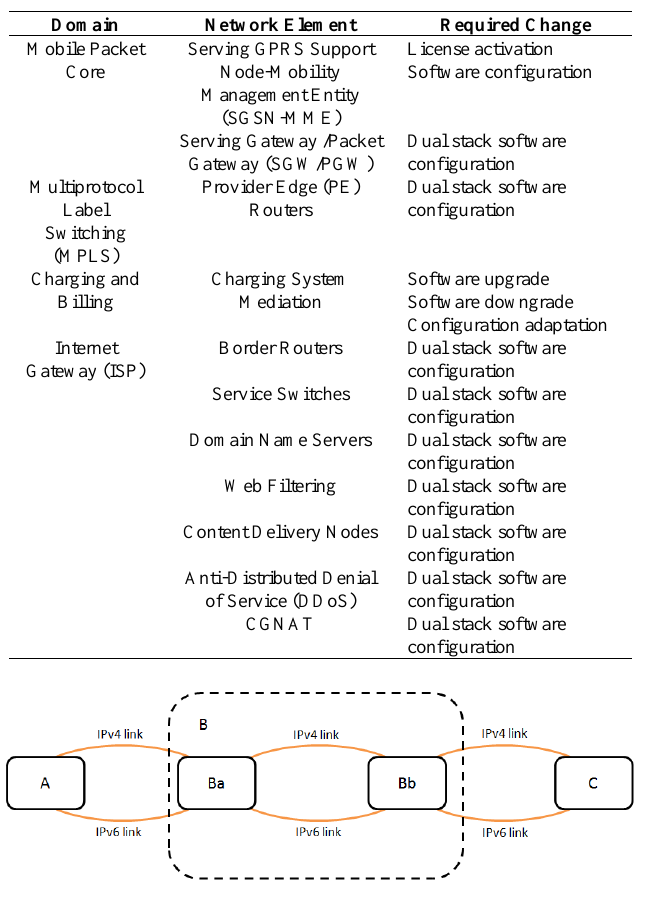
Fig. 6 Measurement model